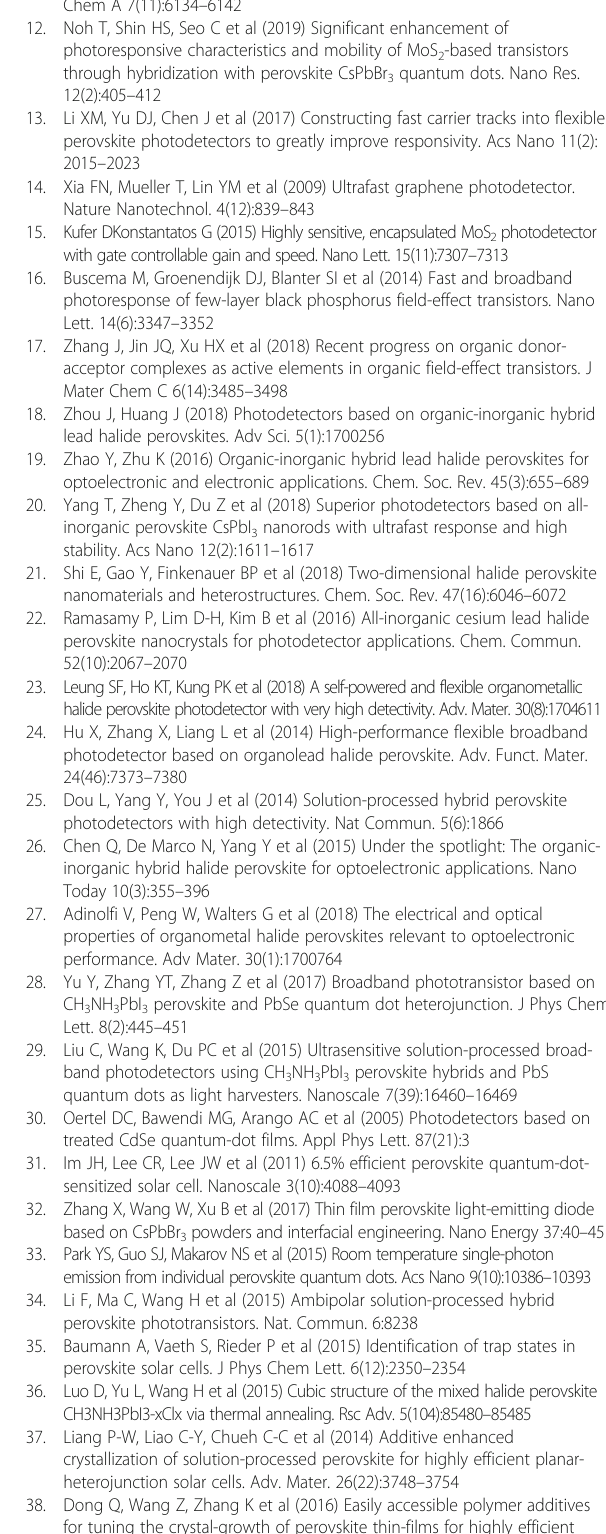
Additional file 1: Figure S1. Tauc equation plot. Figure S2. PL intensity and absorption curve of CsPbBr 3 QDs. (DOCX 421